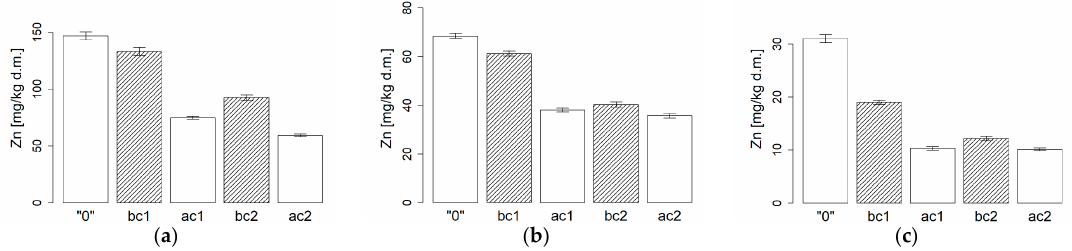
Figure 8. Influence of brown coal and activated carbon on zinc concentrations (after 1 M NH 4 NO 3 extraction) in soils, ( a ) 1:1 ratio; ( b ) 1:3 ratio; ( c ) 1:7